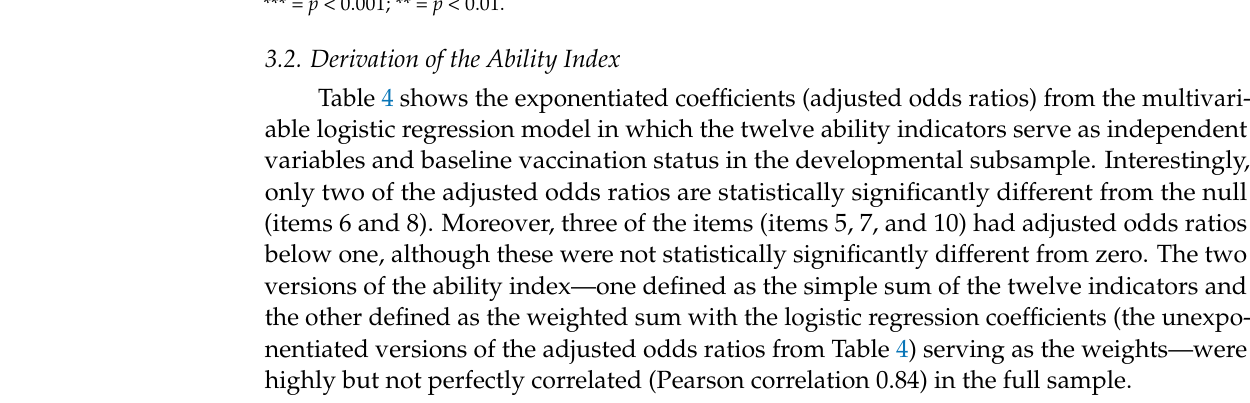
Table 4. Adjusted odds ratios (AORs) and 95% confidence intervals (CIs) from the multiple logistic regression model with ability index items predicting baseline vaccination status in the development sample ( n =